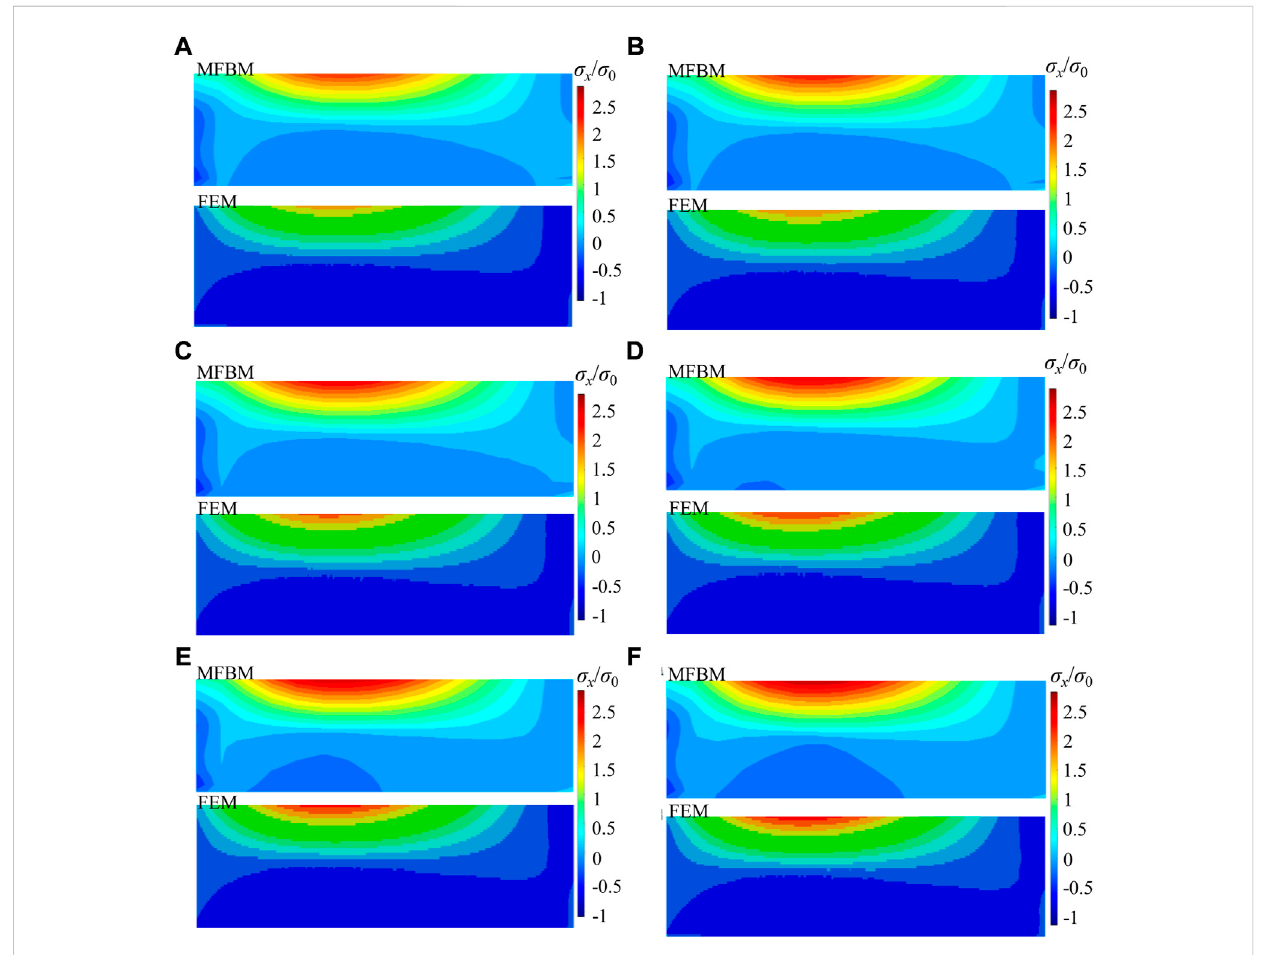
FIGURE 9 Maximum principalstress/load gradient distributions with h 1 =20 cmand h 2 = 20 cm(A:theMFBM; B:theFEM): (A) a= b= 0 cm; (B) a= 20 cmand b = 40 cm; (C) a = 40 cm and b = 80 cm; (D) a = 60 cm and b = 120 cm; (E) a = 80 cm and b = 160 cm; (F) a = 100 cm and b = 200 cm.